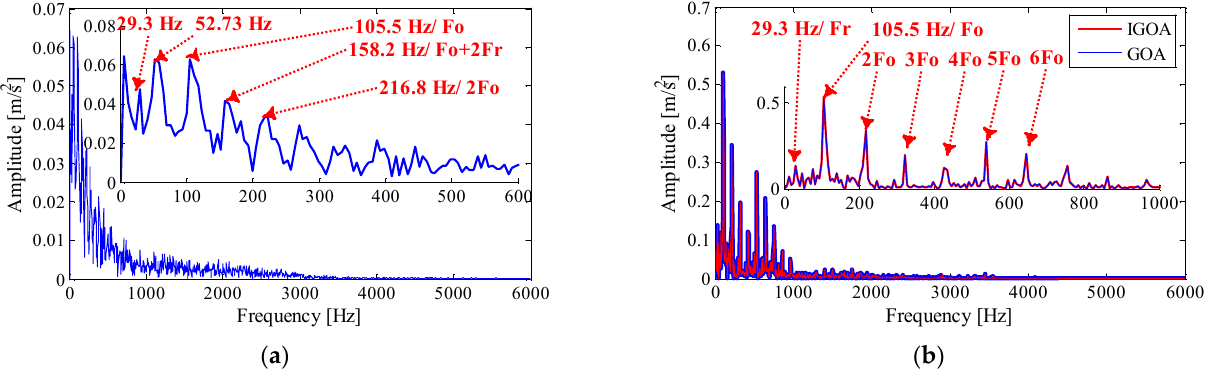
Figure 19. The envelope spectrum of the sensitive IMF obtained by ( a ) TVF-EMD with assigned parameters, and ( b ) TVF-EMD based on IGOA and GOA.